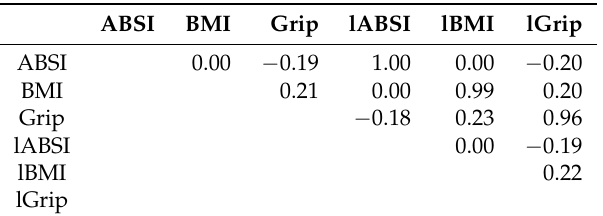
Table 1. Correlations of body and strength measures.